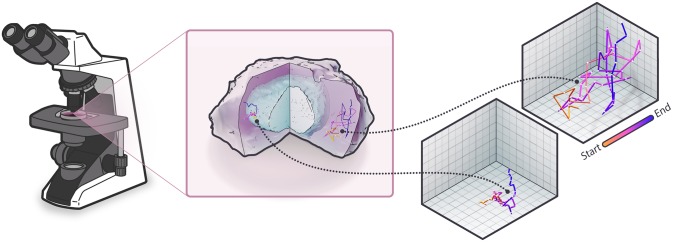
Single particle tracking.In SPT, a live cell is imaged over a series of time points. Individual punctate objects are localized at each time-step, and these positions are traced from frame to frame to produce individual time-lapse trajectories.